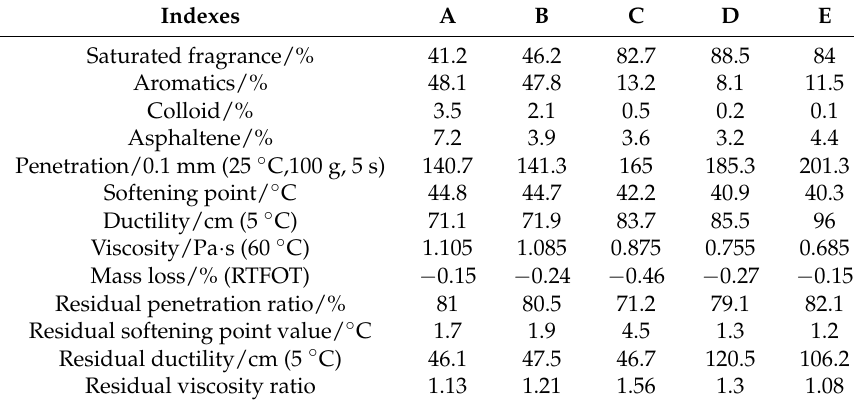
Table 1. The components and indexes of the reducing